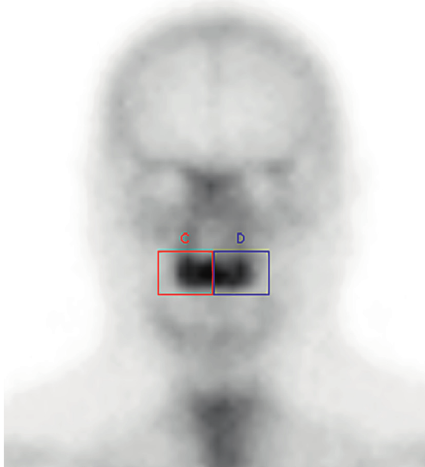
Figure 1: Representative image pixel measurement in the ROI.